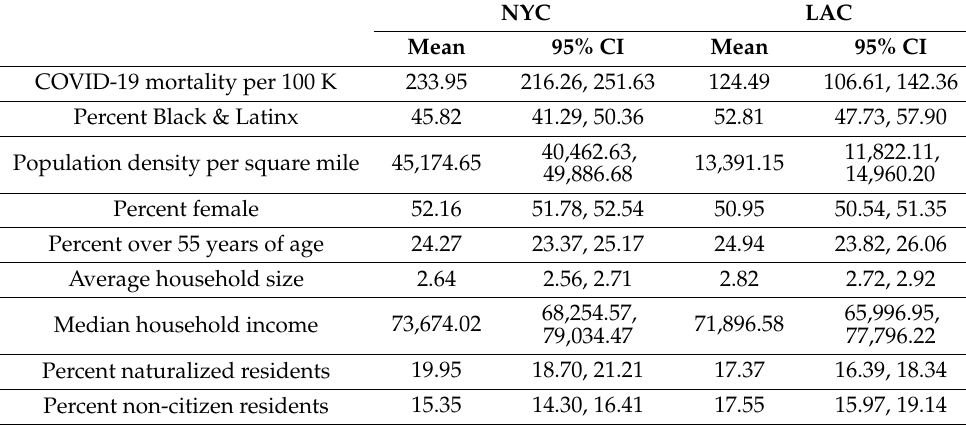
Table 1. NYC ZCTA-level and LAC Community-Level Descriptive